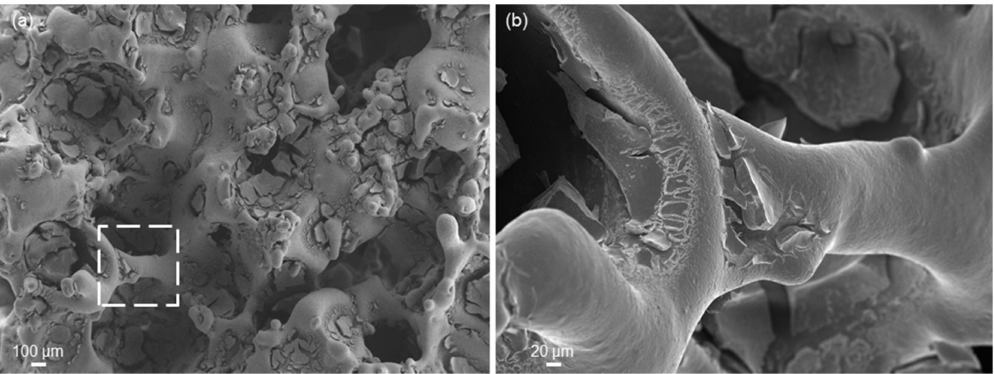
Figure 9. SEM micrographs of ( a ) the porous structure of 5Cu-MBG-SCNA scaffold (magnification 100 × ) and ( b ) detail of a trabecula (dashed square in ( a )) coated by the MBG layer (magnification 500 × ).